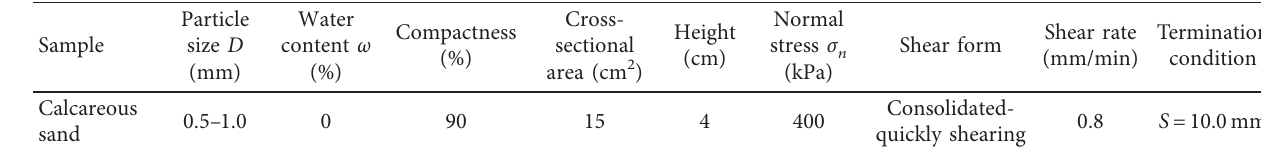
Table 3: Experimental design